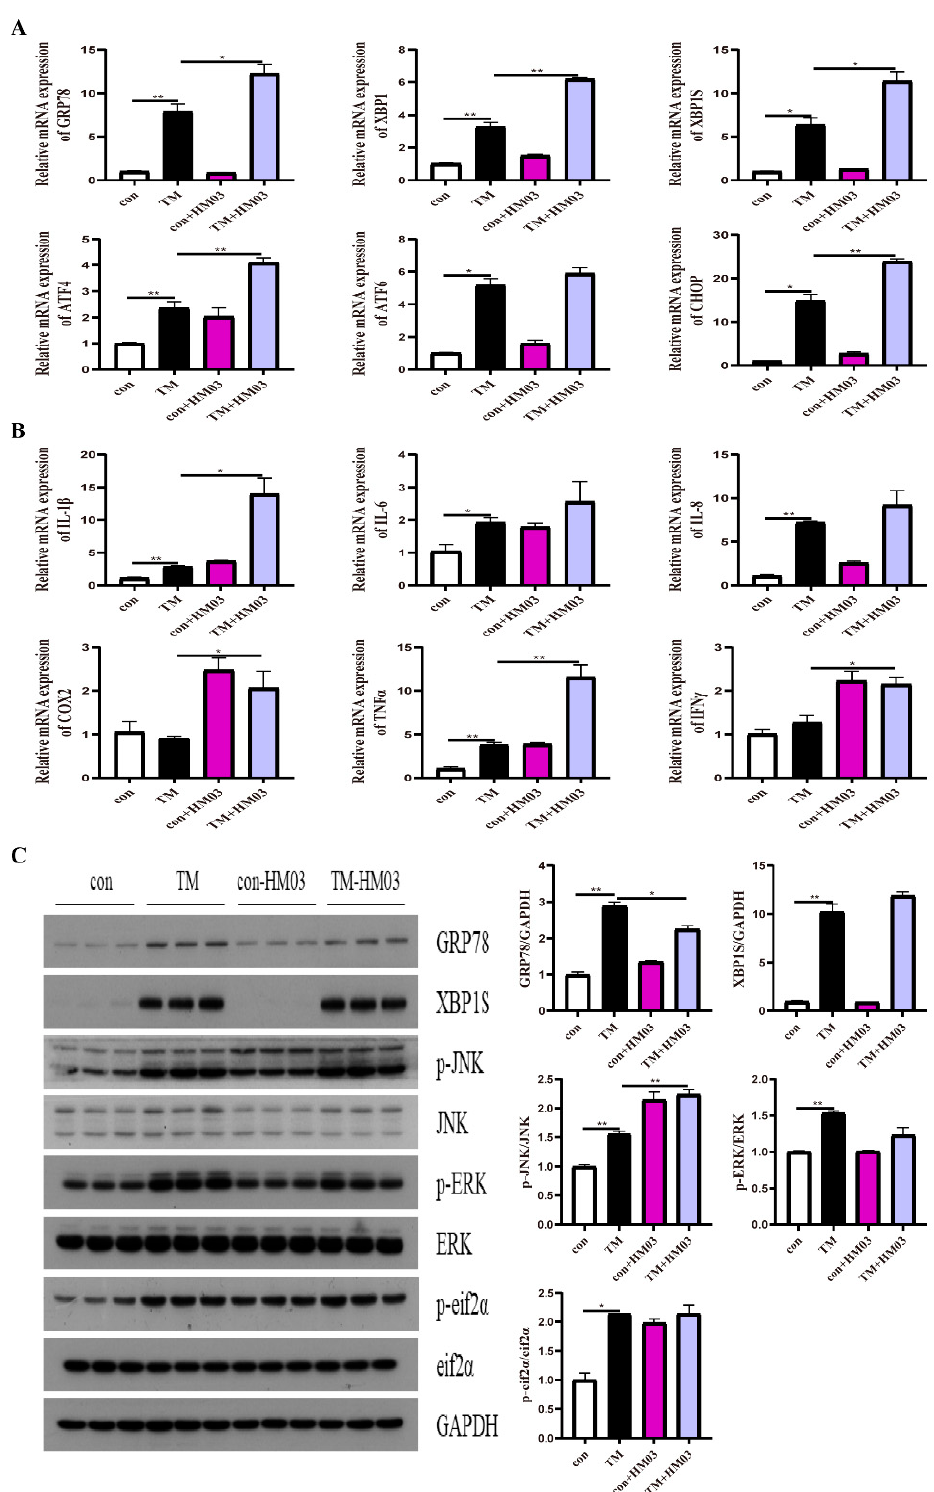
Figure 7. Effects of 10 µ M HM03 treatment for 4 h after 1 µ M TM incubation for 16 h on ER stress and inflammation in macrophages of large yellow croakers. ( A ) Relative mRNA expression of ER stress-related genes. ( B ) Relative mRNA expression of inflammatory genes. ( C ) Protein levels of ER stress-related proteins and inflammatory-related proteins. Values are presented as mean ± SEM ( n = 3). * Significant difference ( p < 0.05); ** highly significant difference ( p < 0.01).